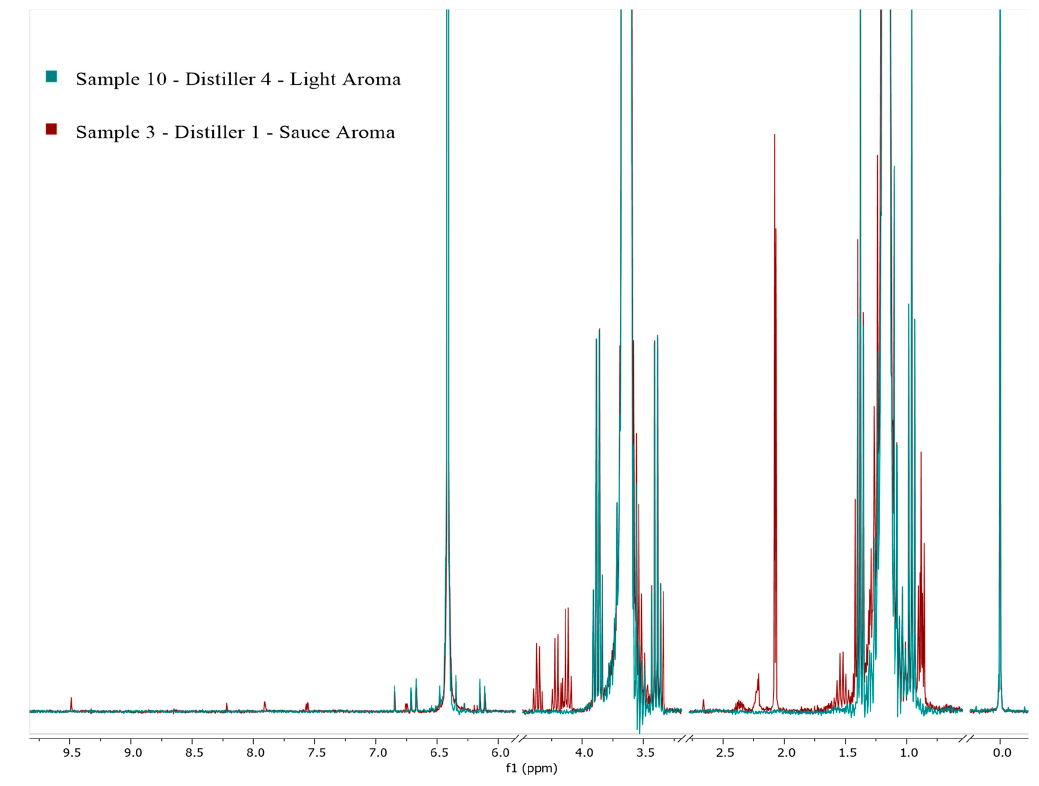
Figure 7. Superimposed 1 H NMR spectra showing a suspected counterfeit baijiu (sample 10, green) containing only ethanol and no congener chemistry compared to a typical baijiu (sample 3, red), which shows the obvious congener signals from furfural (peaks 6.7 to 9.5 ppm), ethyl ester (4.0–4.5 ppm), acetaldehyde, acetic acid (2–2.5 ppm), and higher alcohols (0.85–0.95 ppm).